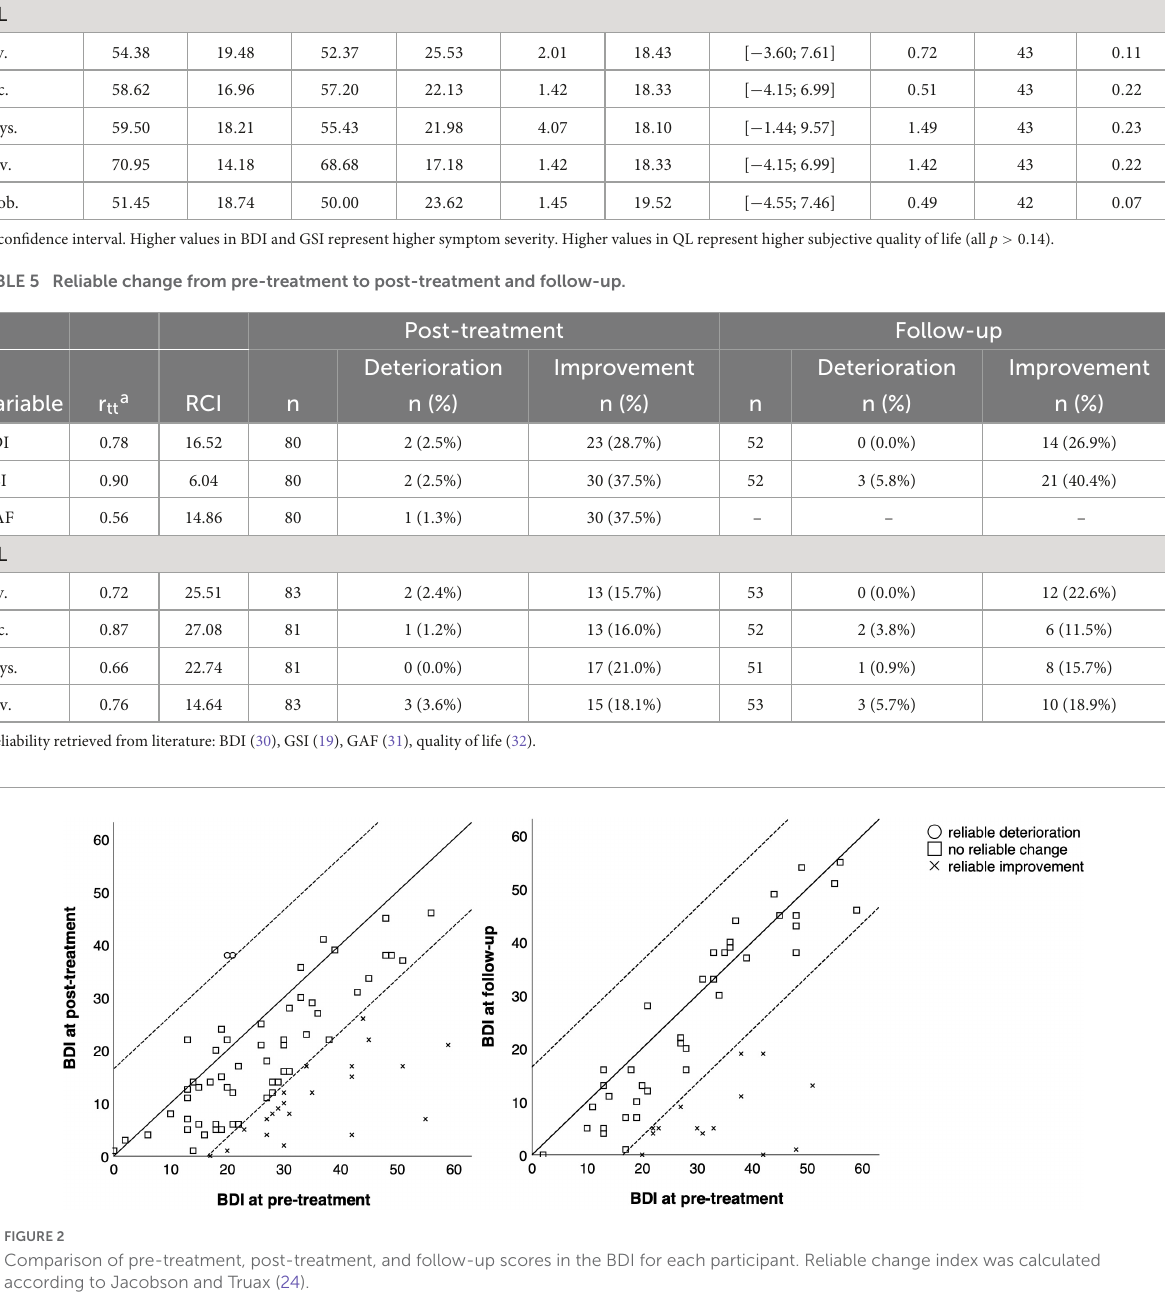
and follow-up and particularly in the domains of